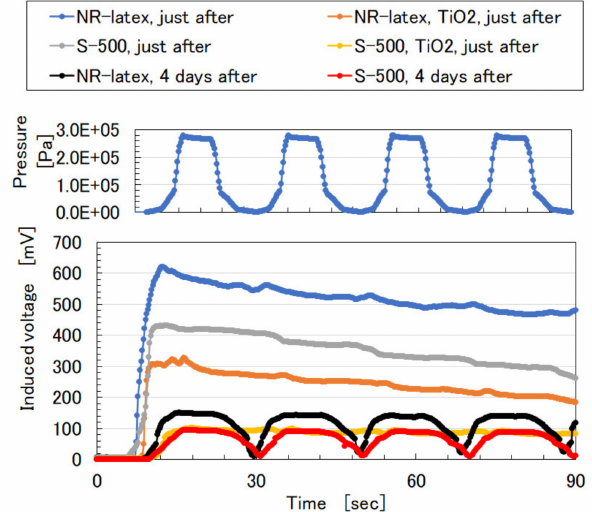
Figure 2. Induced voltage of MCF rubber with U to repeat pressure application: either NR-latex or S-500 is compounded; TiO 2 presents the use of TiO 2 ; “just after” means the measurement just after the production; “4 days after” means the measurement from the production after 4